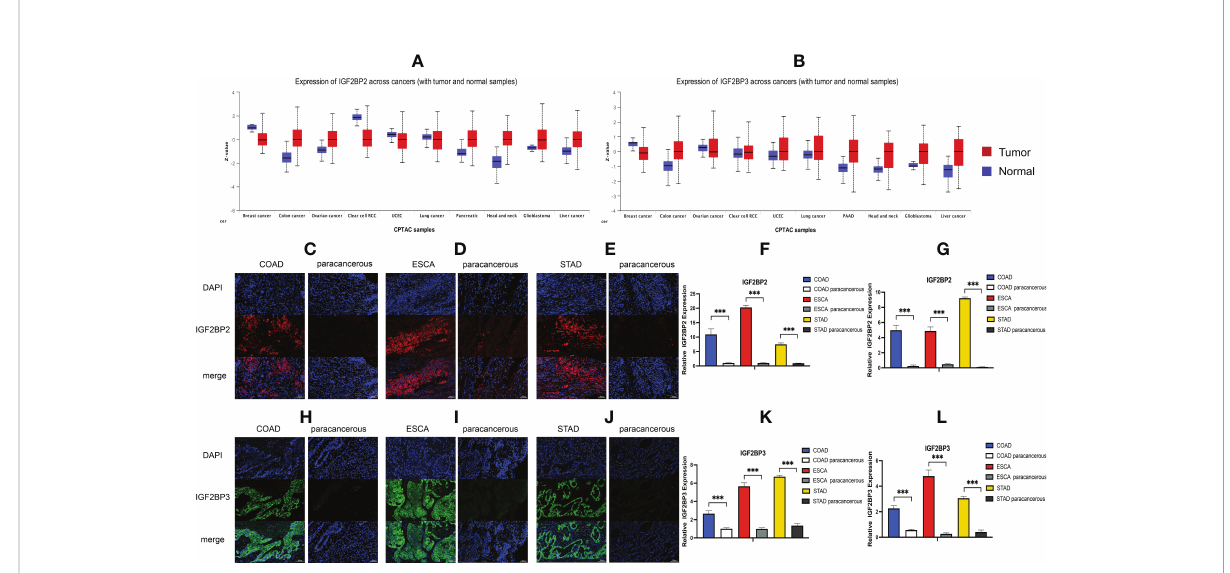
FIGURE 2 Expression level of IGF2BP2 and IGF2BP3 in COAD, ESCA and STAD cancer tissues. (A, B) IGF2BP2/3 protein expression levels among normal tissue and primary tissue were compared based on the CPTAC dataset. Immuno fl uorescence of IGF2BP2 (red) in validated cancer tissues and adjacent tissues. Representative immuno fl uorescence images are presented in validated cancer tissues (C) COAD, (D) ESCA and (E) STAD and adjacent tissues. (F) Immunoreactivity of IGF2BP2 was quanti fi ed. (G) The mRNA expression of IGF2BP2 in validated cancer tissues and adjacent tissues by RT-qPCR. Immuno fl uorescence of IGF2BP3 (green) in validated cancer tissues and adjacent tissues. Representative immuno fl uorescence images are presented in validated cancer tissues (H) COAD, (I) ESCA and (J) STAD and adjacent tissues. (K) Immunoreactivity of IGF2BP3 was quanti fi ed. (L) The mRNA expression of IGF2BP3 in validated cancer tissues and adjacent tissues by RT-qPCR. Data are mean ± SEM (n = 3 per group). *P < 0.05, **P < 0.01, ***P <